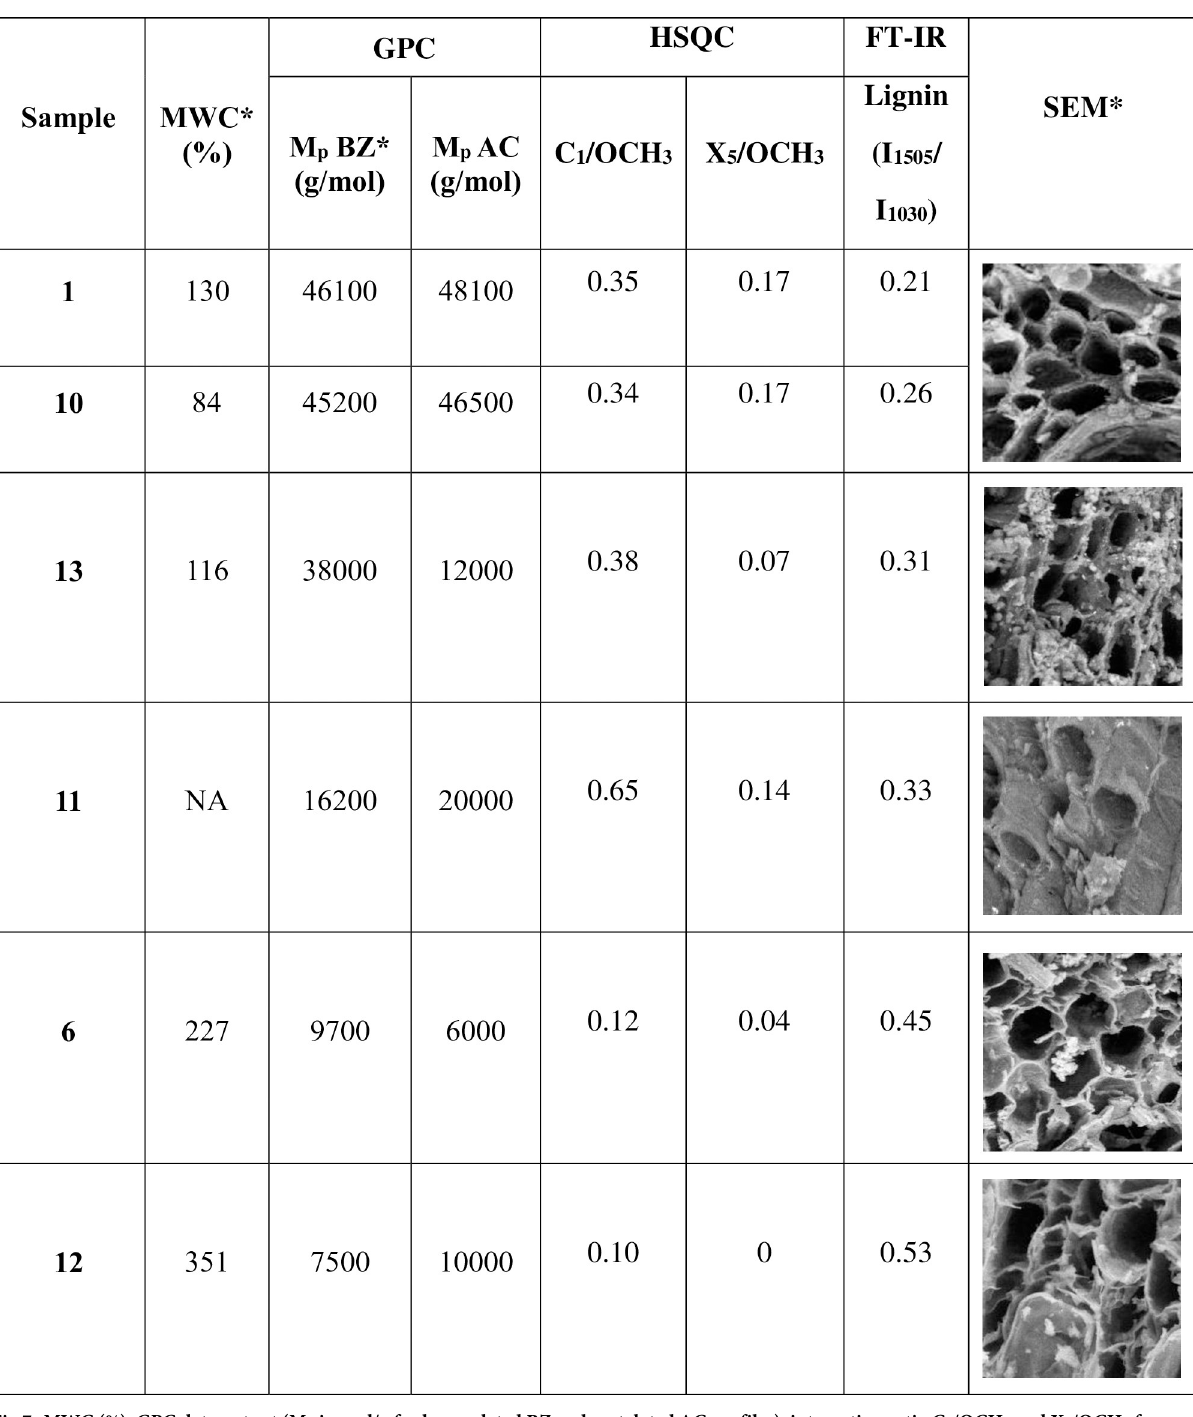
Fig 7. MWC (%), GPC data output (M p in mol/g for benzoylated BZ and acetylated AC profiles), integration ratio C 1 /OCH 3 and X 5 /OCH 3 from HSQC spectra, intensity ratio 1505/1030 cm -1 from FT-IR spectra, and SEM images for the archaeological samples 1, 10, 13, 11, 6 and 12. � Analysed in